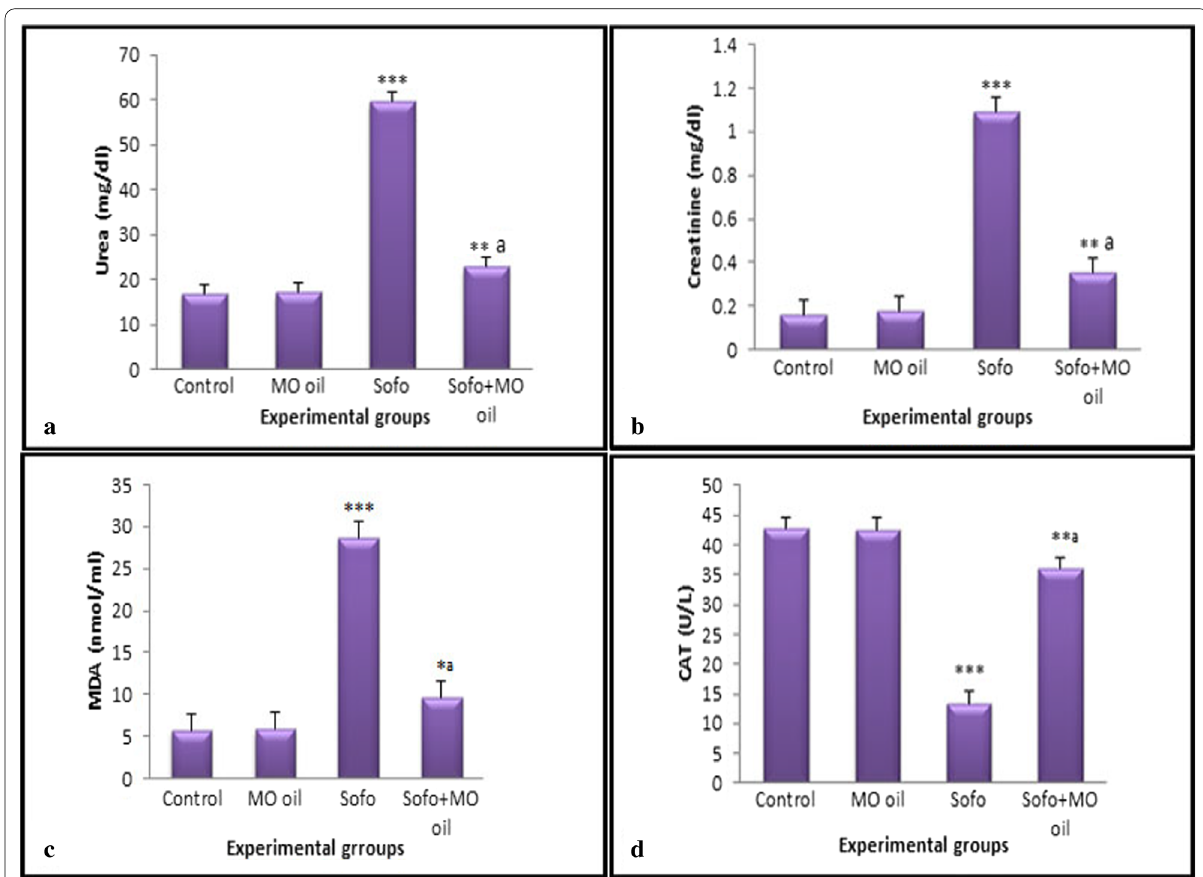
Fig. 6 Levels of a urea, b creatinine, c MDA and d CAT activity in sera of animals of the different experimental groups. ( ⁎ ) p < 0.05, ( ⁎⁎ ) p < 0.001 and ( ⁎⁎⁎ ) p < 0.0001significant comparing with control group. ( a ) p < 0.0001 significant comparing with sofo